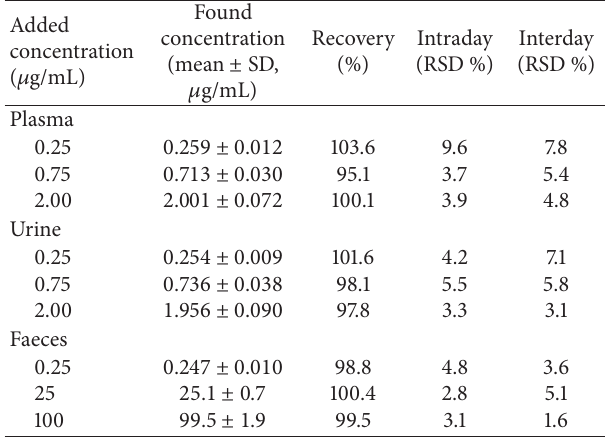
Table 1: Summary of precision and accuracy of ergosterol in rat plasma, urine, and